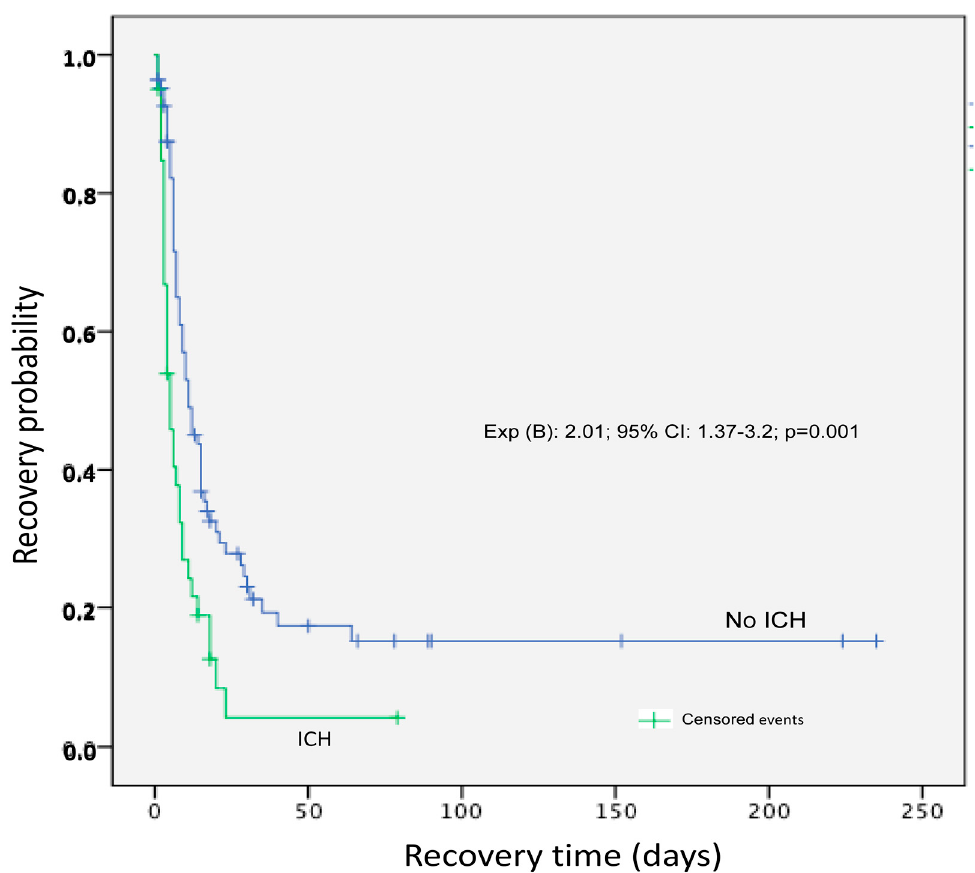
Figure 3. Kaplan–Meier (KM) curve showing recovery probability for severely injured patients with intracranial hypertension. Censored events shown by vertical hash marks, corresponding to alive hospital discharges, and in-hospital deaths recorded as events. Although not a significant predictor of in-hospital mortality in multivariate regression analysis, KM product-limit estimator showed a significant difference for an unfavorable outcome for those who had intracranial hypertension (log rank chi-square = 11.16, p = 0.001). Table 2. Descriptive statistics by outcome group.